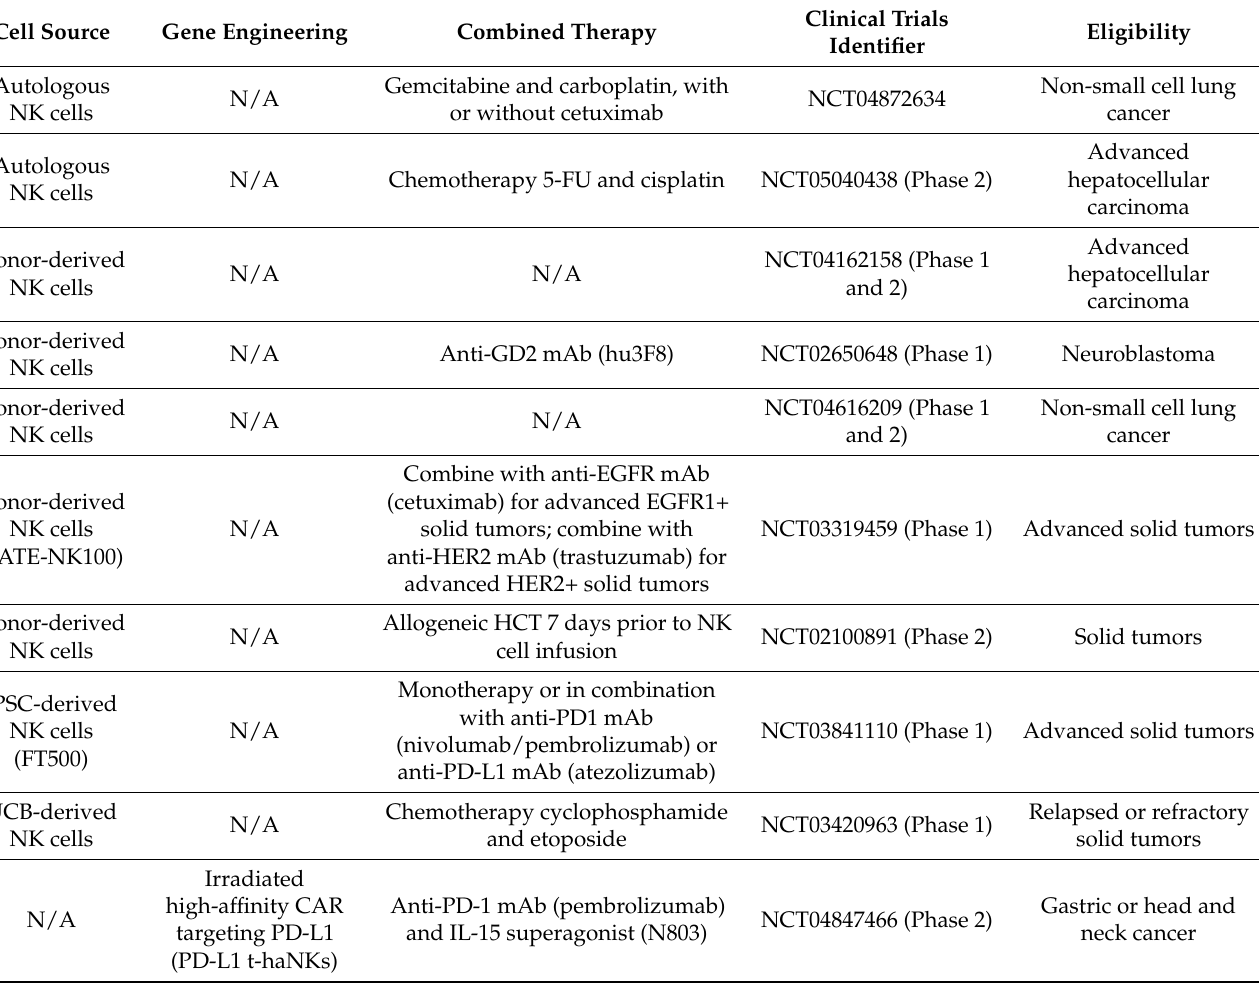
Table 2. Selected ongoing clinical trials using adoptive NK cell